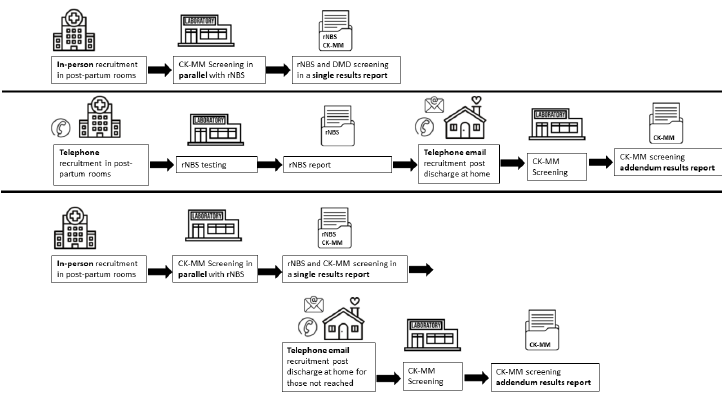
Figure 1. Recruitment, testing and reporting for the Duchene muscular dystrophy newborn screening. The three time periods of recruitment are depicted: pre-pandemic ( top line), remote recruitment during the start of the pandemic ( middle line), and hybrid recruitment ( bottom line). During hybrid recruitment, phone and email recruitment were used to recruit babies who were delivered on weekends or holidays or were not available to recruit while they were in the hospital. Abbreviations: routine newborn screening (rNBS), creatine kinase-MM